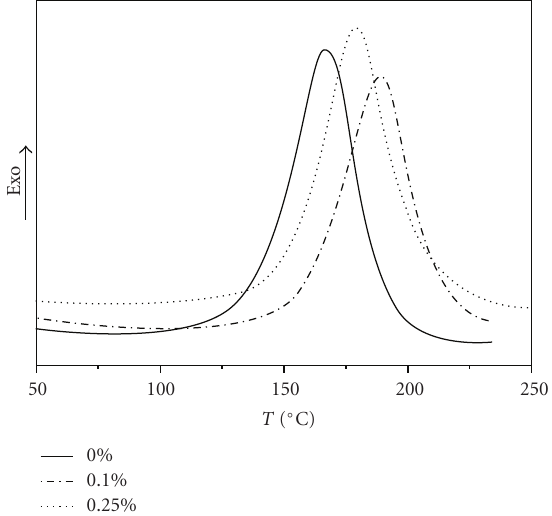
Figure 1: Dynamic DSC thermograms of stoichiometric mixtures ( r = 1) with di ff erent amino-functionalized CNT content.